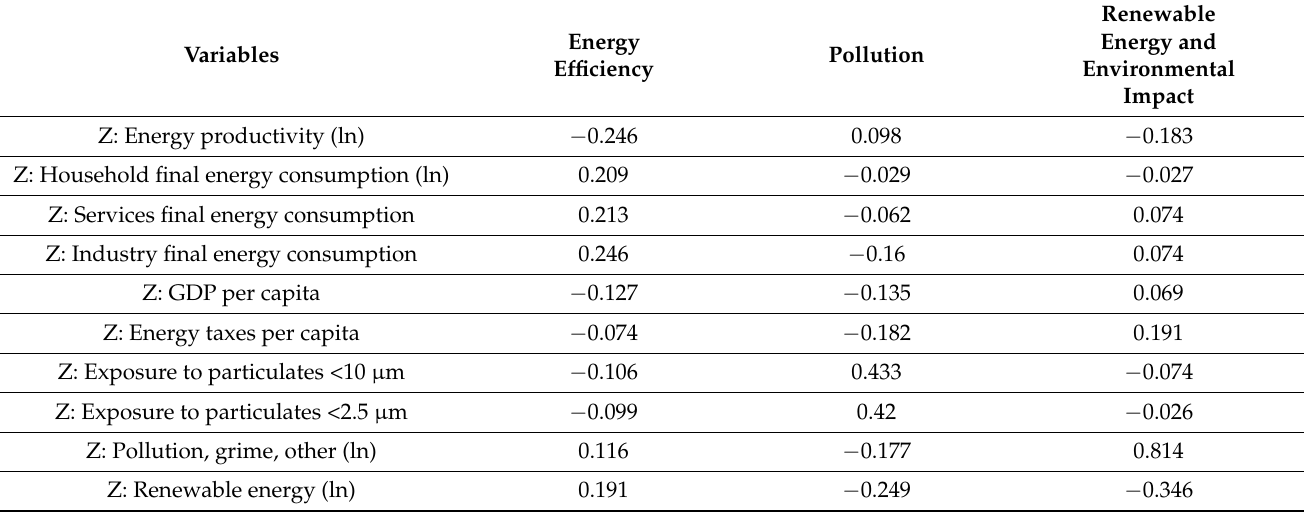
Table 7. Component Score Coefficient